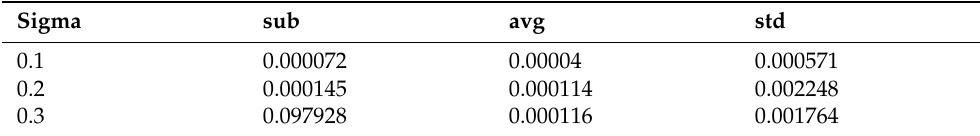
Table 4. Related error results under different sigma on simulation